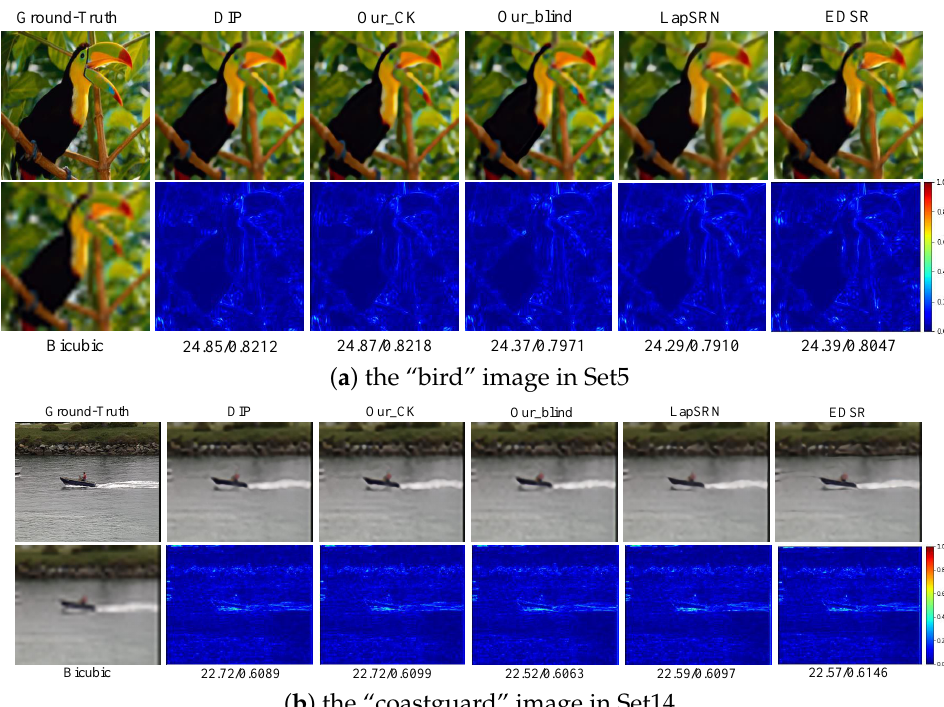
Figure 2. Comparison of the visualization results of the recovered HR images of different SOTA methods. The first row denotes the resulting HR images, while the second row gives the difference images between the recovered and the ground-truth